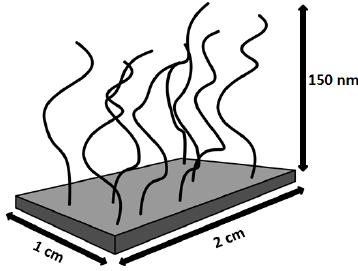
Figure 8. Determination of particle number densities using a box model.